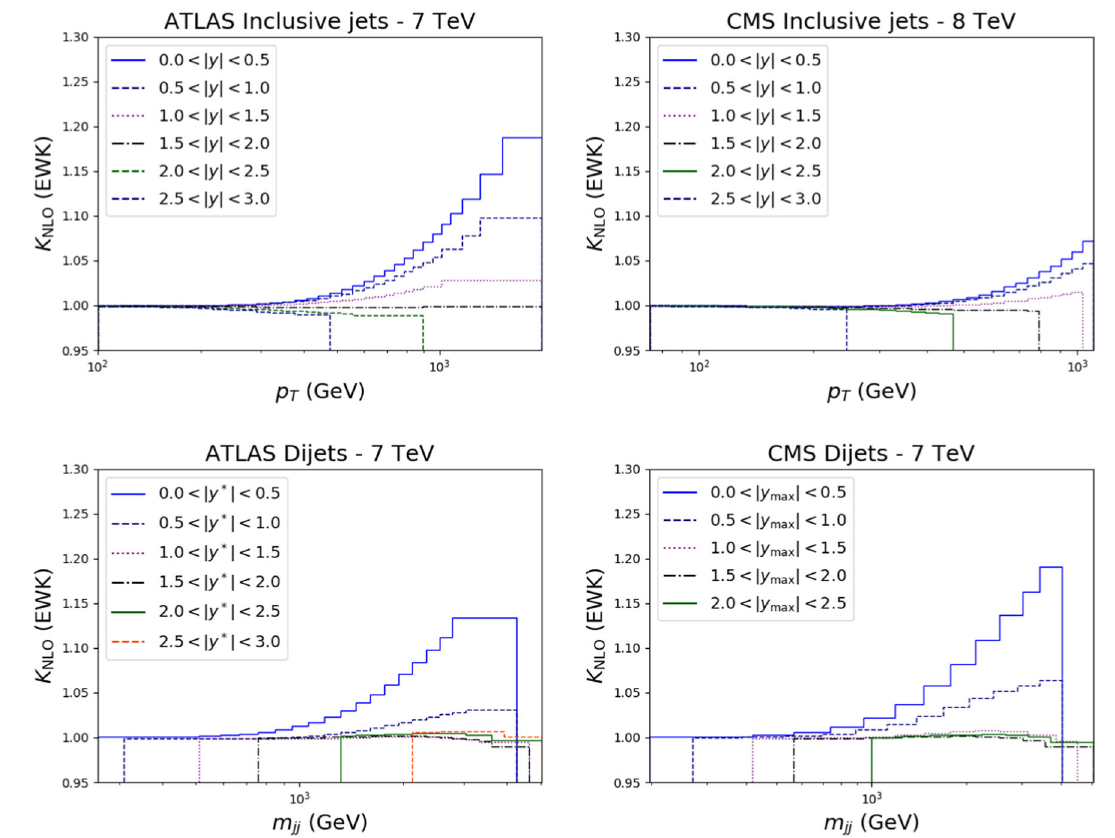
Fig. 3 The EW K -factors, Eq. (3.3), for the ATLAS and CMS single- inclusive (top) and dijet (bottom) measurements. For single-inclusive jets the K -factors are shown as a function of jet p T in six different